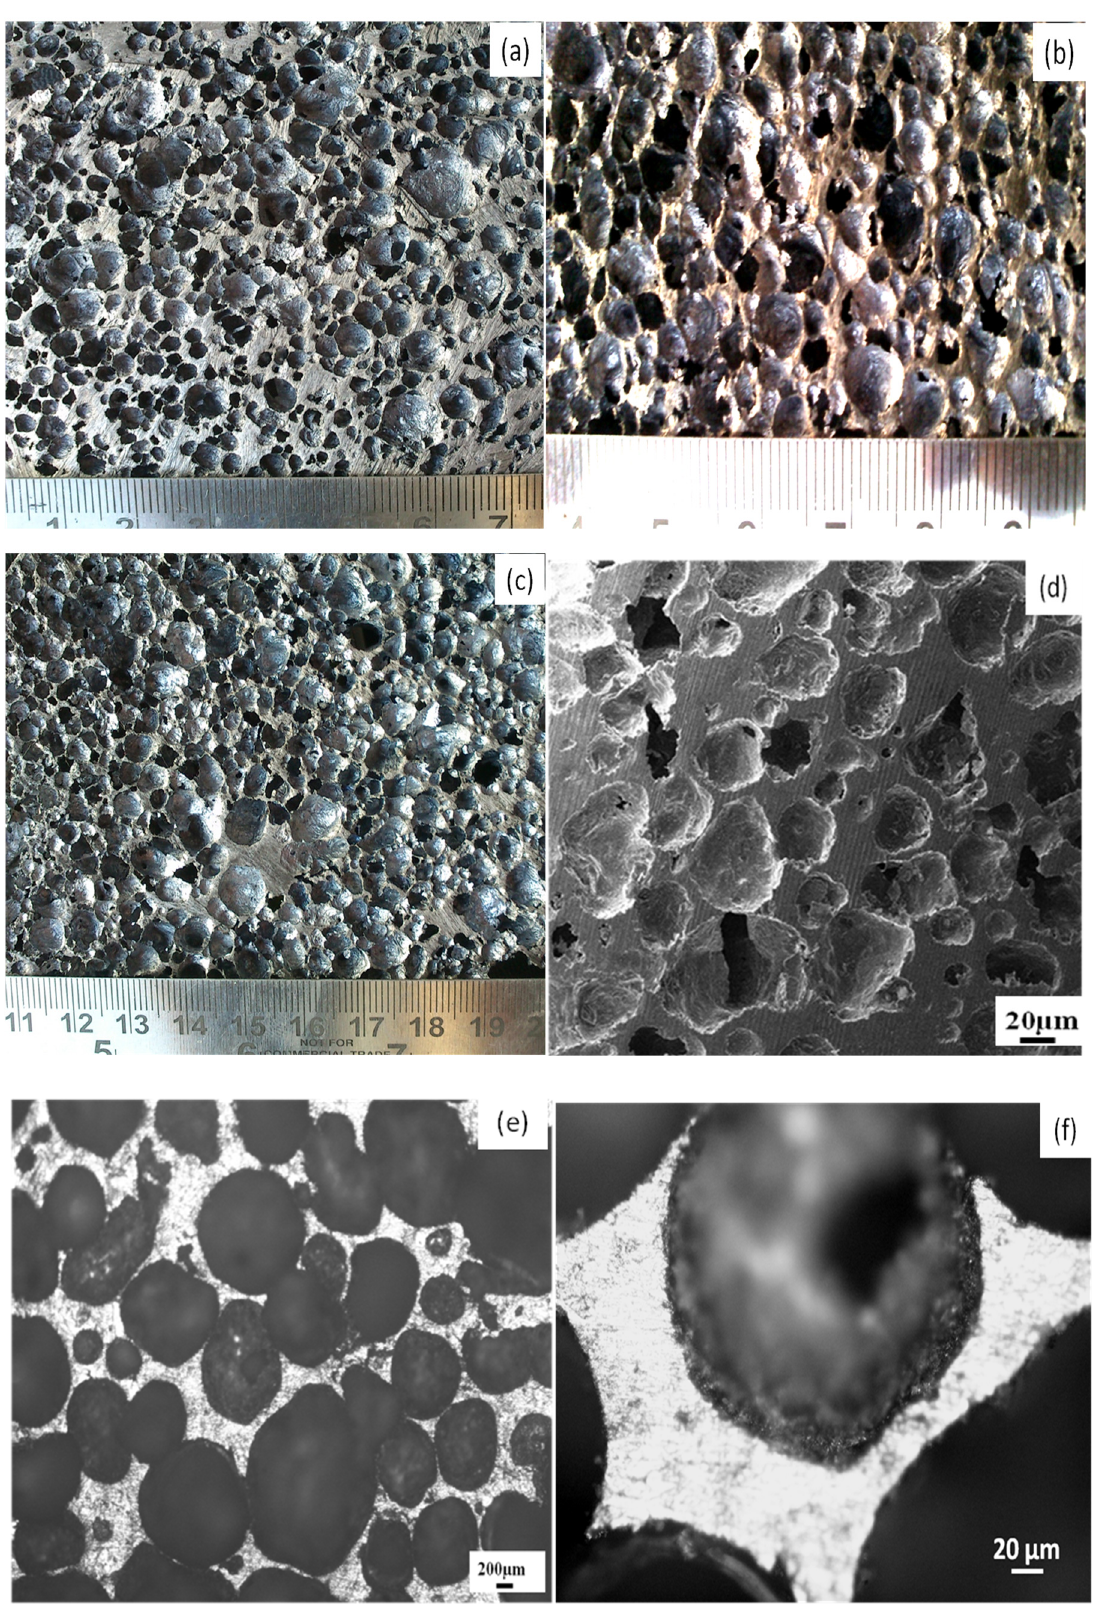
Figure 5. The images of aluminum foam composites with 2 wt.% blowing agent CaCO 3 at ( a ) 850 °C, ( b ) 875 °C, ( c ) 900 °C, ( d ) SEM image; and optical images ( e ) and ( f ) of composites foam at 900 °C.